Question: Compose a caption that would accompany this figure in a paper.
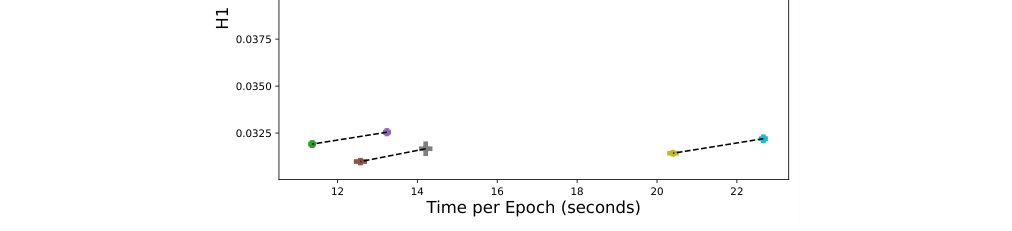
Answer: Comparison of the Full-FNO and Mixed-FNO with different frequency modes on the Darcy Flow dataset. For 16 frequency modes, the half precision error (compared to full precision) is higher than for 32, 64, or 128 modes.